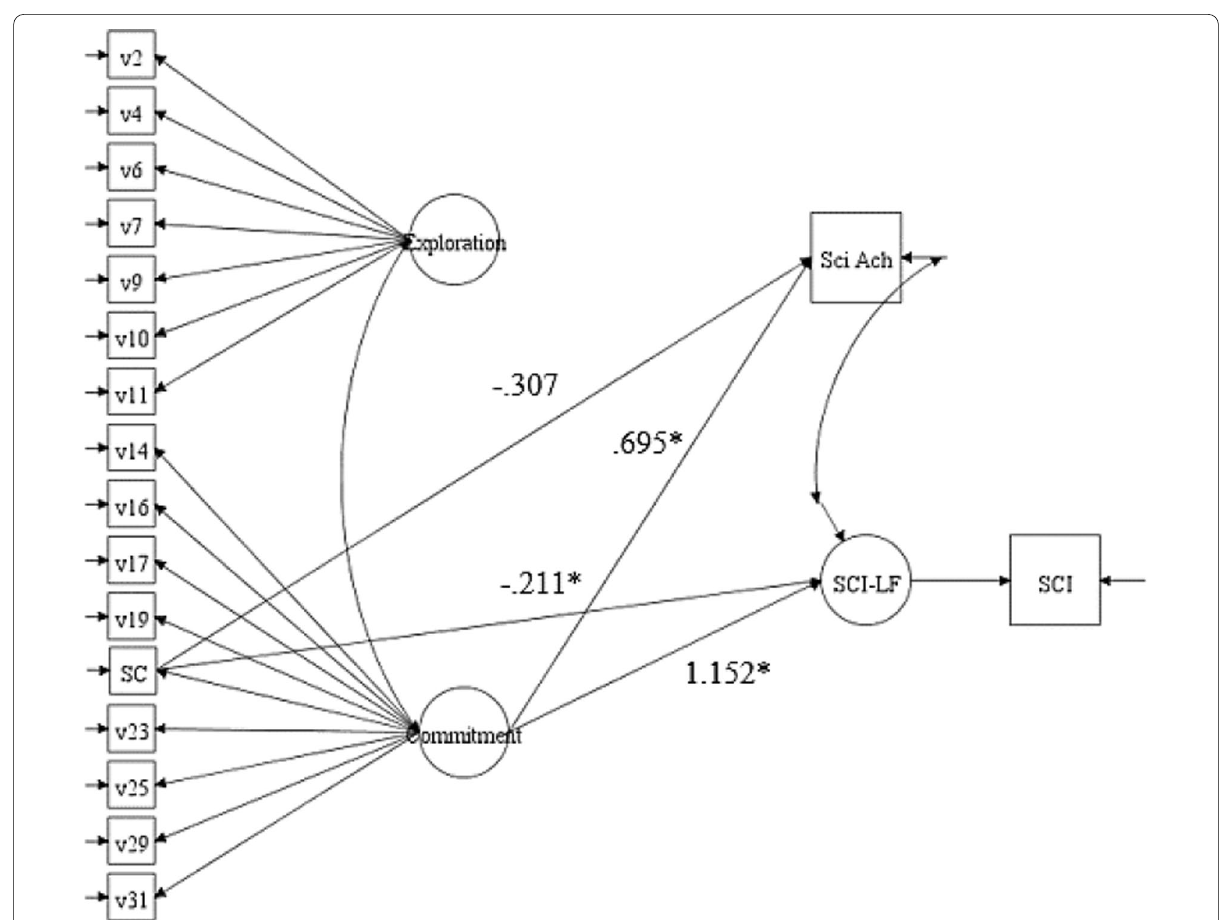
Fig. 3 Unconstrained SEM for testing the divergent validity of science identity and science self‑concept. * p < 0.05. All path coefficients are standardized. Science SC Science Self‑Concept (“I view myself as a science person.”); Sci Ach = variable based upon student academic success in science and the rigor of the science courses the student pursued); SCI‑LF Interest Latent Factor; SCI Science Career Interest (measured as a composite score of the Science Subscale from the =